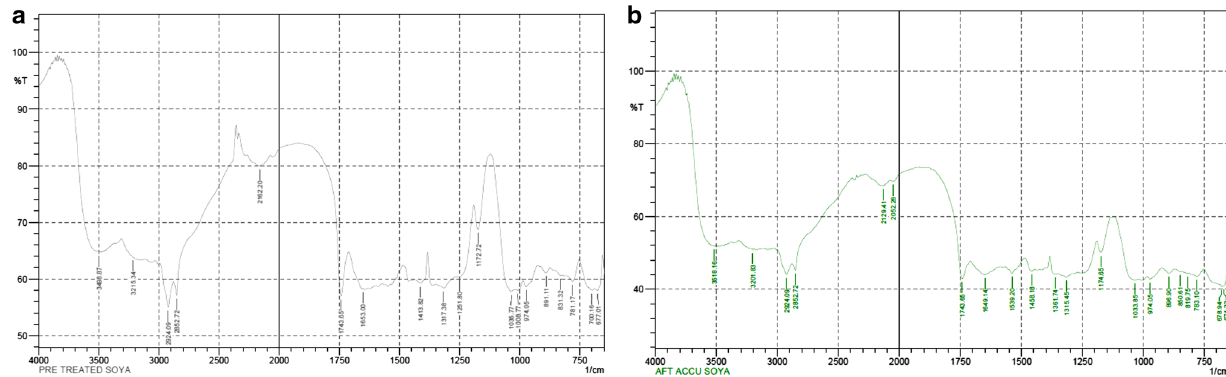
Fig. 2 FT-IR spectra of soya bean adsorbent before ( a ) and after ( b )